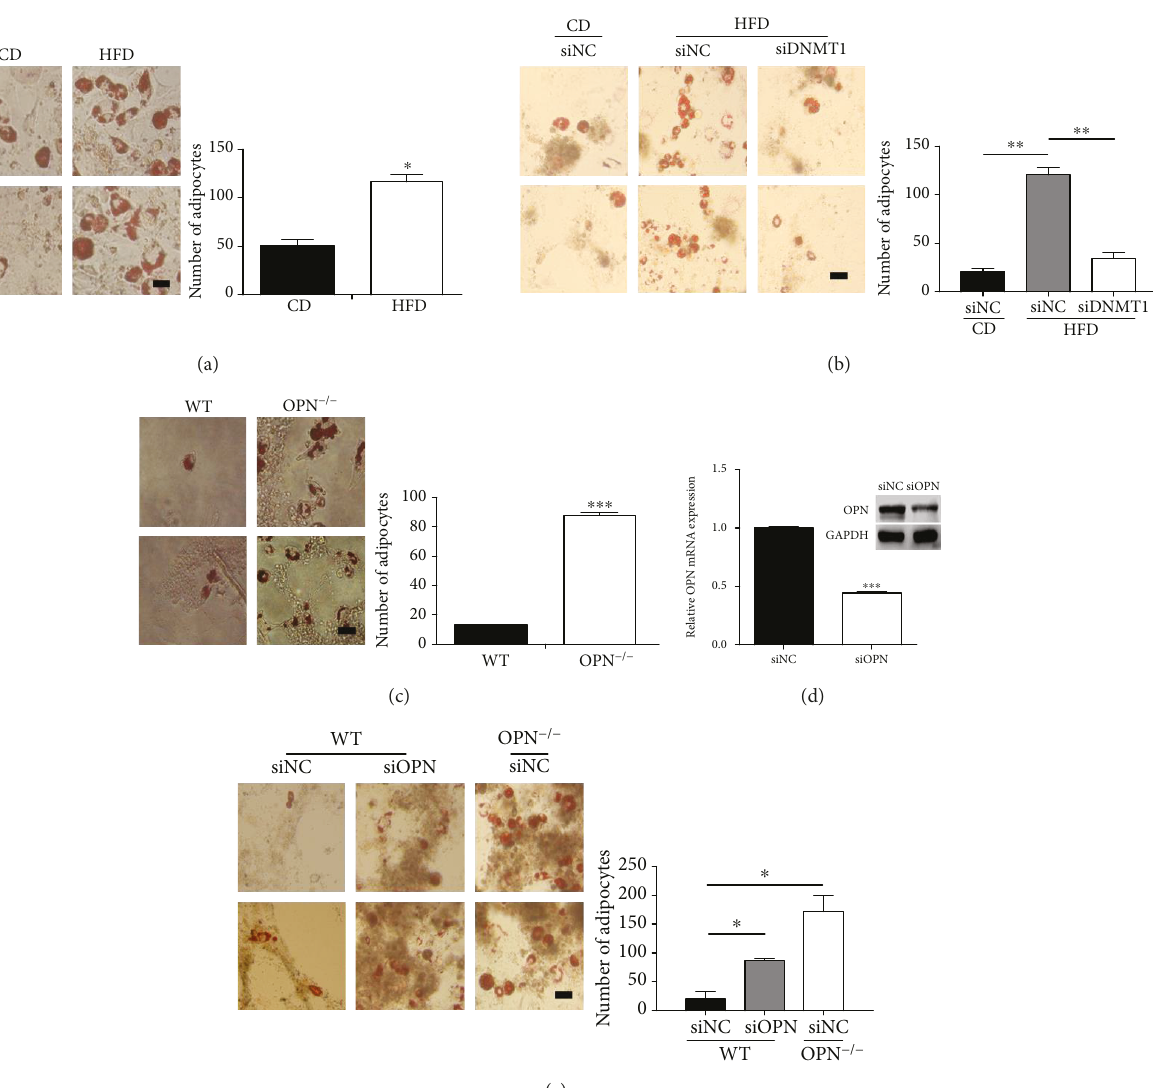
Figure 3: OPN de fi ciency accelerates ASC di ff erentiation into adipocytes. (a) ASCs from CD mice or from HFD mice were cultured in adipogenic di ff erentiation medium for 4 days and stained with Oil Red O to reveal lipid droplets. (b) CD and HFD ASCs, transfected with DNMT1 siRNA (siDNMT1) or control siRNA (siNC), were cultured in adipogenic di ff erentiation medium for 3 days and stained with Oil Red O to reveal lipid droplets. (c) Wild-type or OPN − / − ASCs were cultured in adipogenic di ff erentiation medium for 3 days and stained with Oil Red O to reveal lipid droplets. (d) Wild-type ASCs transfected with OPN siRNA (siOPN) or control siRNA (siNC) were analyzed for OPN mRNA and protein 3 days after transfection, to verify knockdown e ffi ciency. (e) Two groups of ASCs were subjected to adipogenic di ff erentiation medium for 6 days and stained with Oil Red O. Adipocyte size was quanti fi cation analyzed by